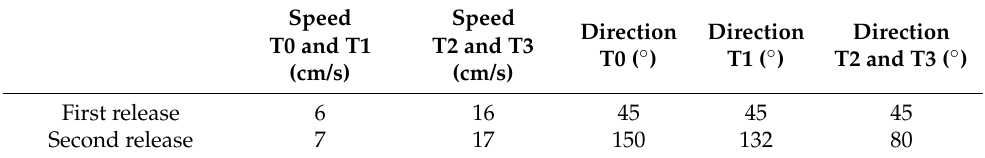
Table 4. Speed and direction of movement of the targets in the survey